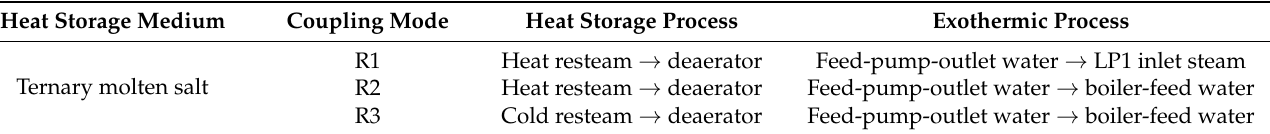
Table 1. Unit coupling system